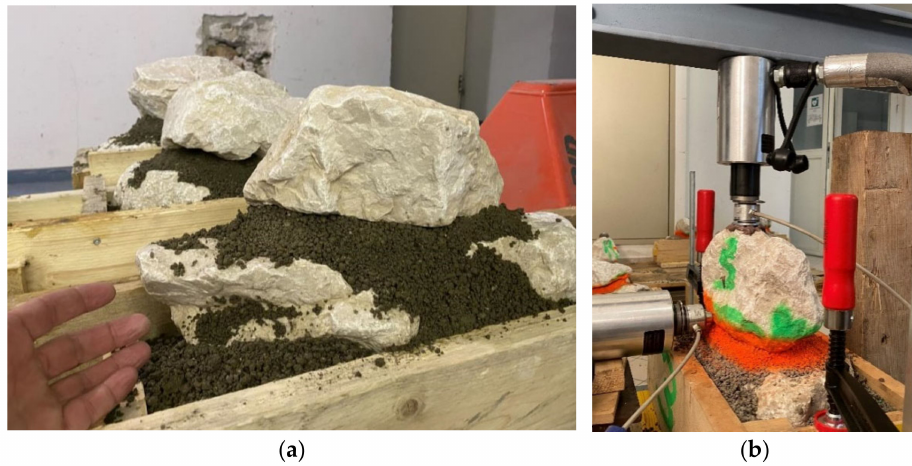
Figure 7. Installing stones for model tests ( a ), application of a constant vertical load and increasing the horizontal force until the failure of the structure ( b